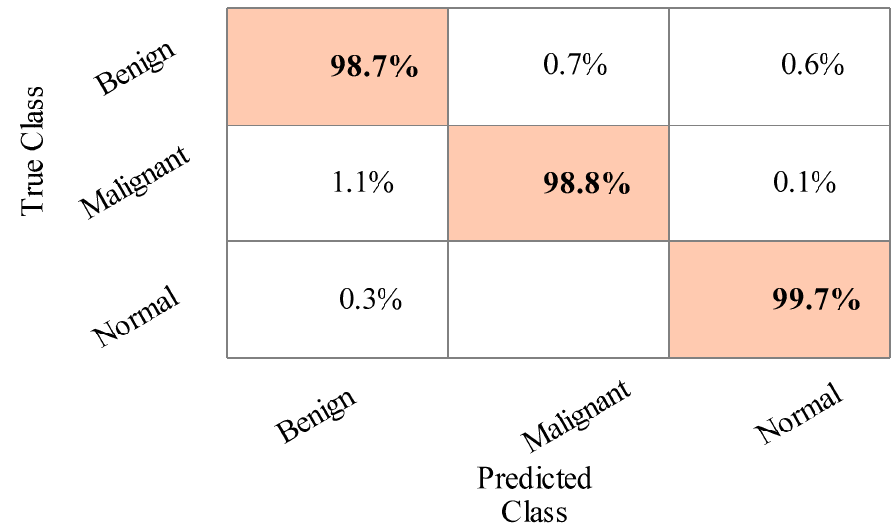
Figure 12. Confusion matrix of Cubic SVM after the proposed feature fusion approach.